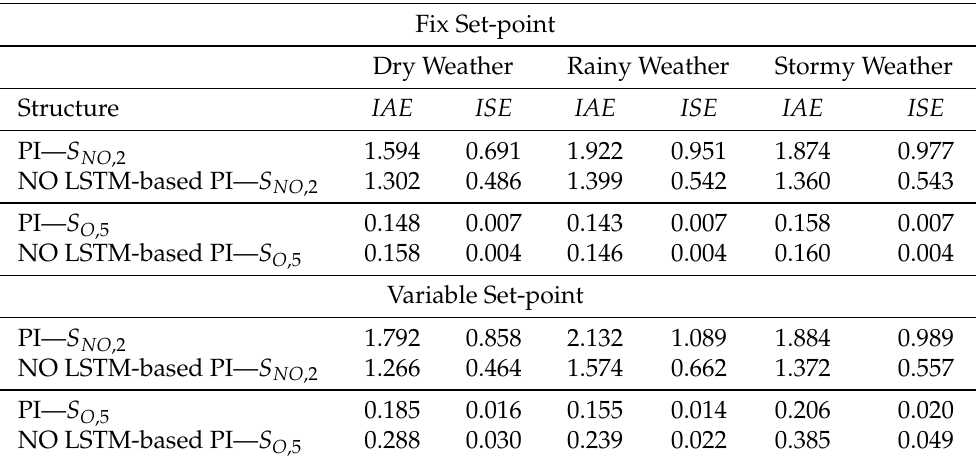
Table 3. Control performance when the NO LSTM-based PI derived from the NO control loop is transferred into the DO control